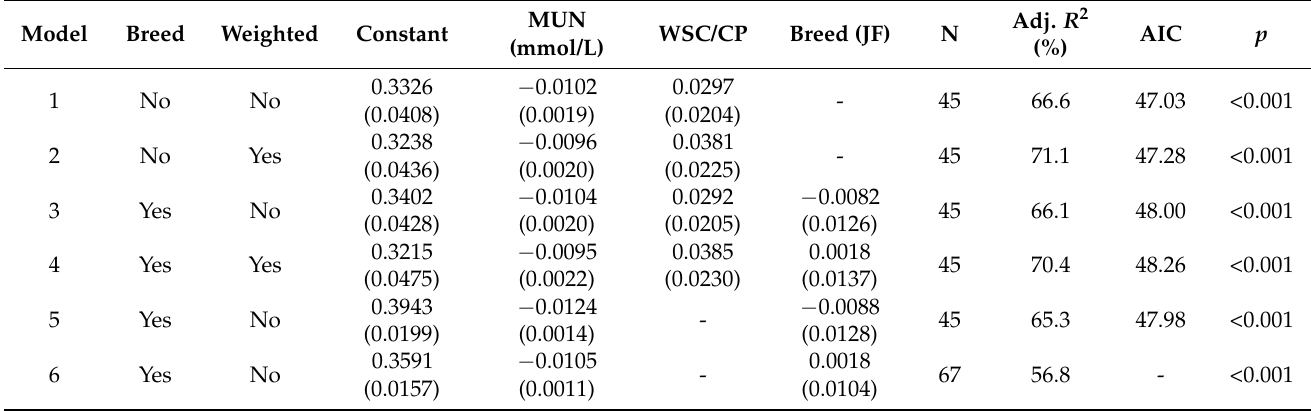
Table 5. Multiple regression models (coefficients (SE)) for NUE produced by all subset regression procedures. The BREED factor was ‘forced’ into Models 3 − 6. N = number of groups means used in each analysis. Some models are given for both unweighted and weighted data. Models 5 and 6 involve the same parameters but using either (Model 5) the same 45 samples used in models 1–4 or (Model 6) all the data available for these parameters.